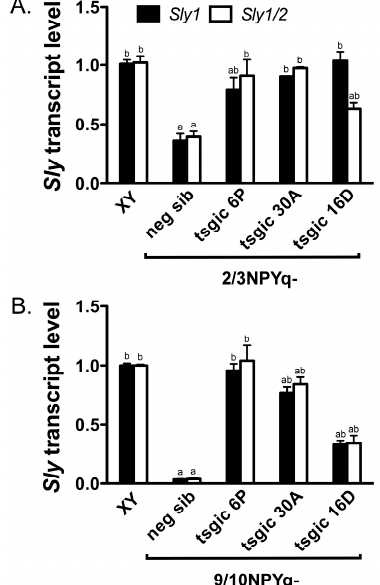
Figure 2. Addition of the Flag-Sly transgene to males with NPYq deletions rescues Sly expression deficiency . Sly transcripts levels ( Sly1 and Sly1/2 global) in whole testes from moderately ( A ) and severely ( B ) NPYq-deficient mice with (tsgic) and without (neg sib) Flag-Sly transgene addition obtained by real-time RT-PCR with Actb as a loading control and normalized to wild-type XY controls. Three transgenic lines were tested: 6P carrying Sly1 and Sly2 transgenes and lines 30A and 16D positive for Sly1 transgene only. There were no differences between XY and neg sib from different transgenic lines so the XY and neg sib data were pooled (the data showing all transgenic lines assayed separately is shown in Figure S6). The graphs are mean ± SEM with n = 14, 14, 9, 3, 4 ( A ) and n = 9, 9, 3, 3, 3 ( B ) for XY, neg sib, and tsgic 6P, 30A and 16D, respectively. Statistical significance ( t -test, p < 0.05): a different than respective transcript type in XY; b different than respective transcript type in neg sib. Primer sequences are shown in Table